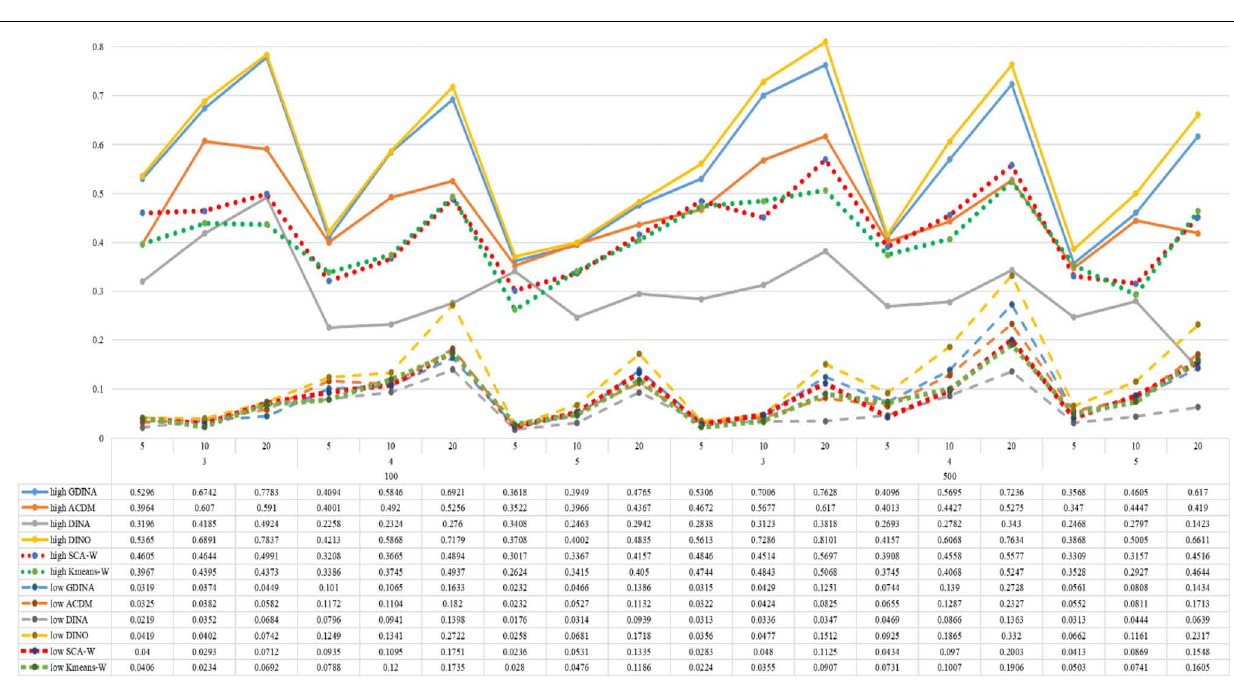
into account both the sample size and the number of parameters of the model (Chen et al., 2013). Based on this point, the A-CDM provides the best fit among these four